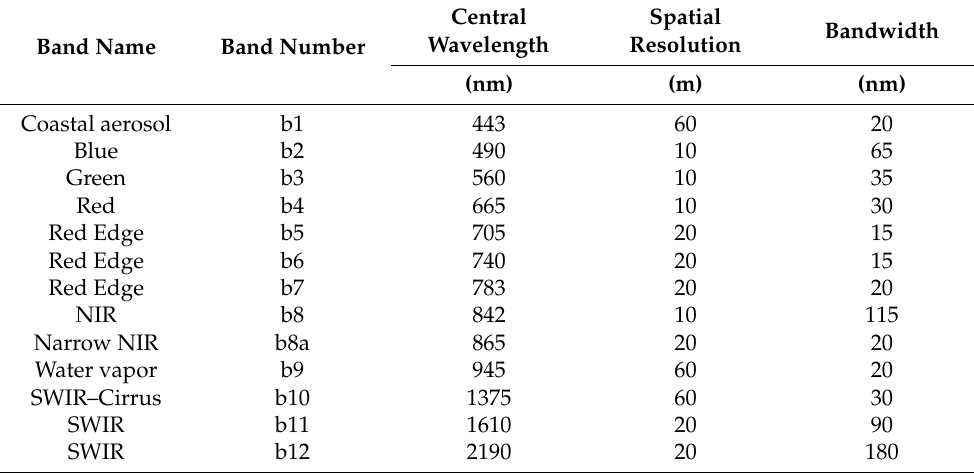
Table 1. Band Information of the Sentinel-2 Multispectral